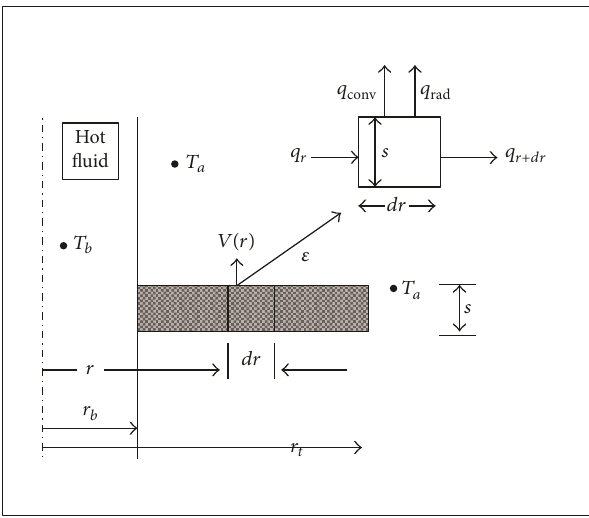
Figure 1: Porous radial fin geometry incorporating the energy balance of a cylindrical cross